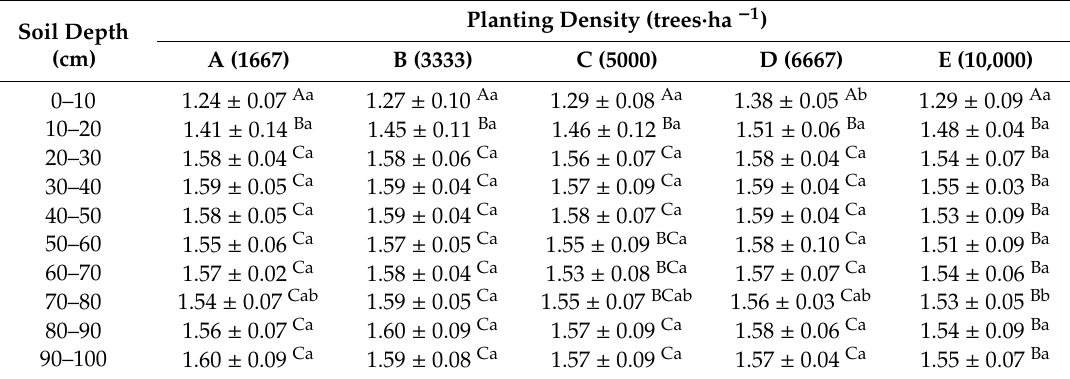
Table 2. Soil bulk density in di ff erent layers under di ff erent stand densities (g · cm − 3